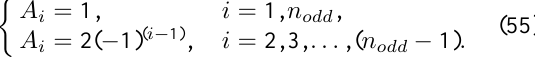
Fig. 8. Input shaping to generate a series of alternating-sign pulses.